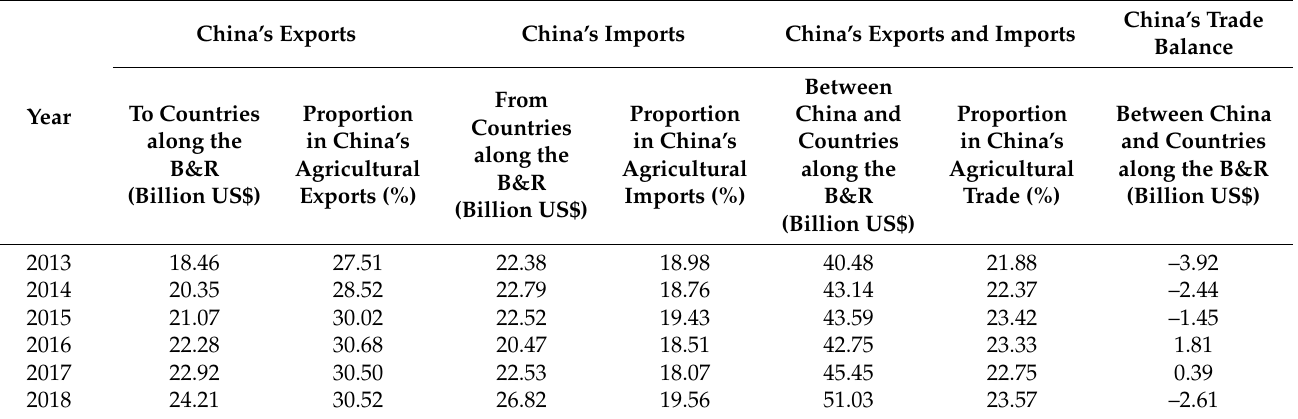
Table 1. The agricultural trade between countries along the B&R and China and its proportion in China’s agricultural trade during